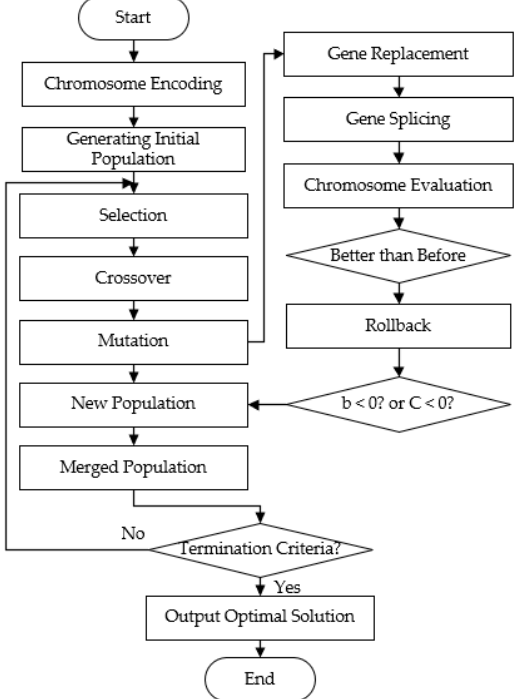
Figure 2. Flow chart of improved GA.